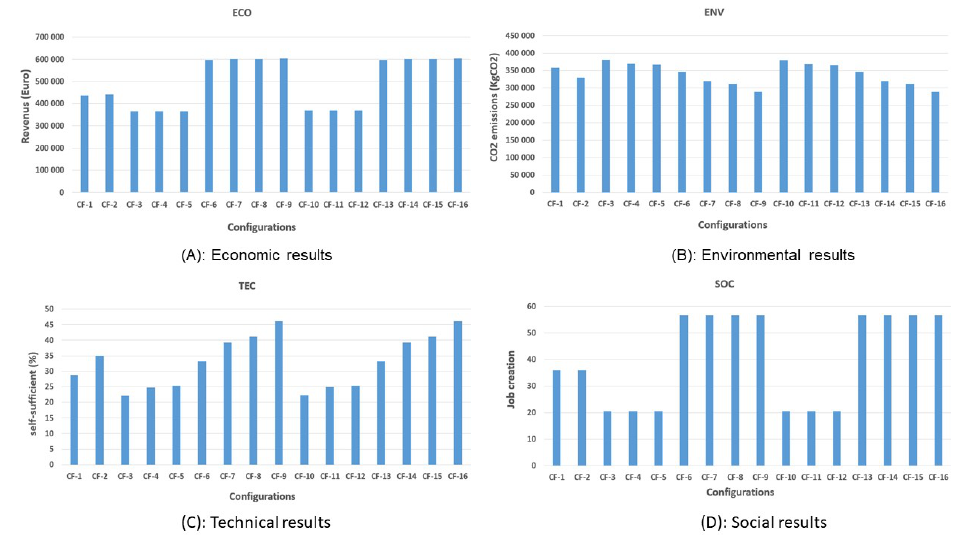
Figure 4. Optimization